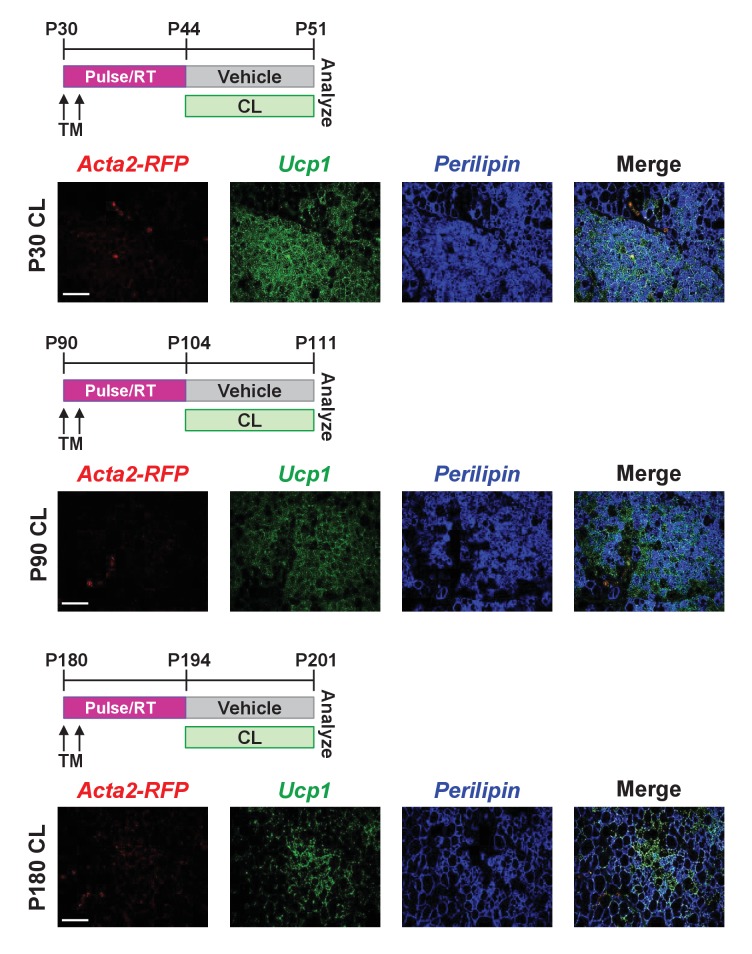
Acta2+ smooth muscle cells are not a source of Adrb3 induced beiging at different ages.(A) Experimental procedure and respresentative IHC staining of TM induce one-month-old Acta2Cre-ERT2; RosaR26RFP; (Acta2-RFP) male mice treated with CL seven days (n = 5/group). (B) Experimental procedure and respresentative IHC staining of TM induce three-month-old Acta2Cre-ERT2; RosaR26RFP; (Acta2-RFP) male mice treated with CL seven days (n = 5/group). (C) Experimental procedure and respresentative IHC staining of TM induce six-month-old Acta2Cre-ERT2; RosaR26RFP; (Acta2-RFP) male mice treated with CL seven days (n = 5/group). Scale Bar = 200 µm.